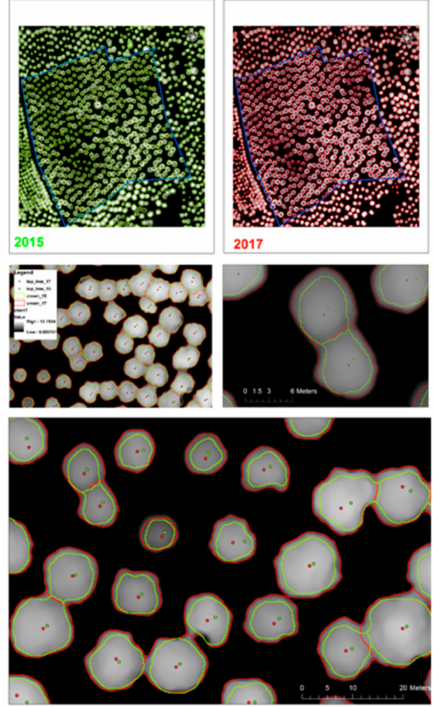
Figure 3. Examples of the canopy height models (CHMs) and crown delineation for 2015 (green outline) and 2017 (red outline) to illustrate changes in height and crown size within the study area.